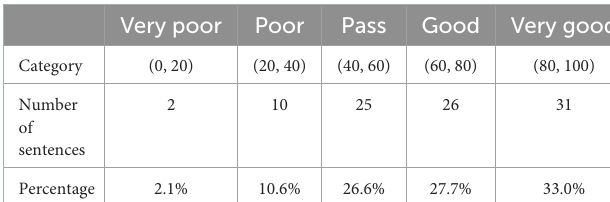
TABLE 2 Score distribution of delivery in five levels of